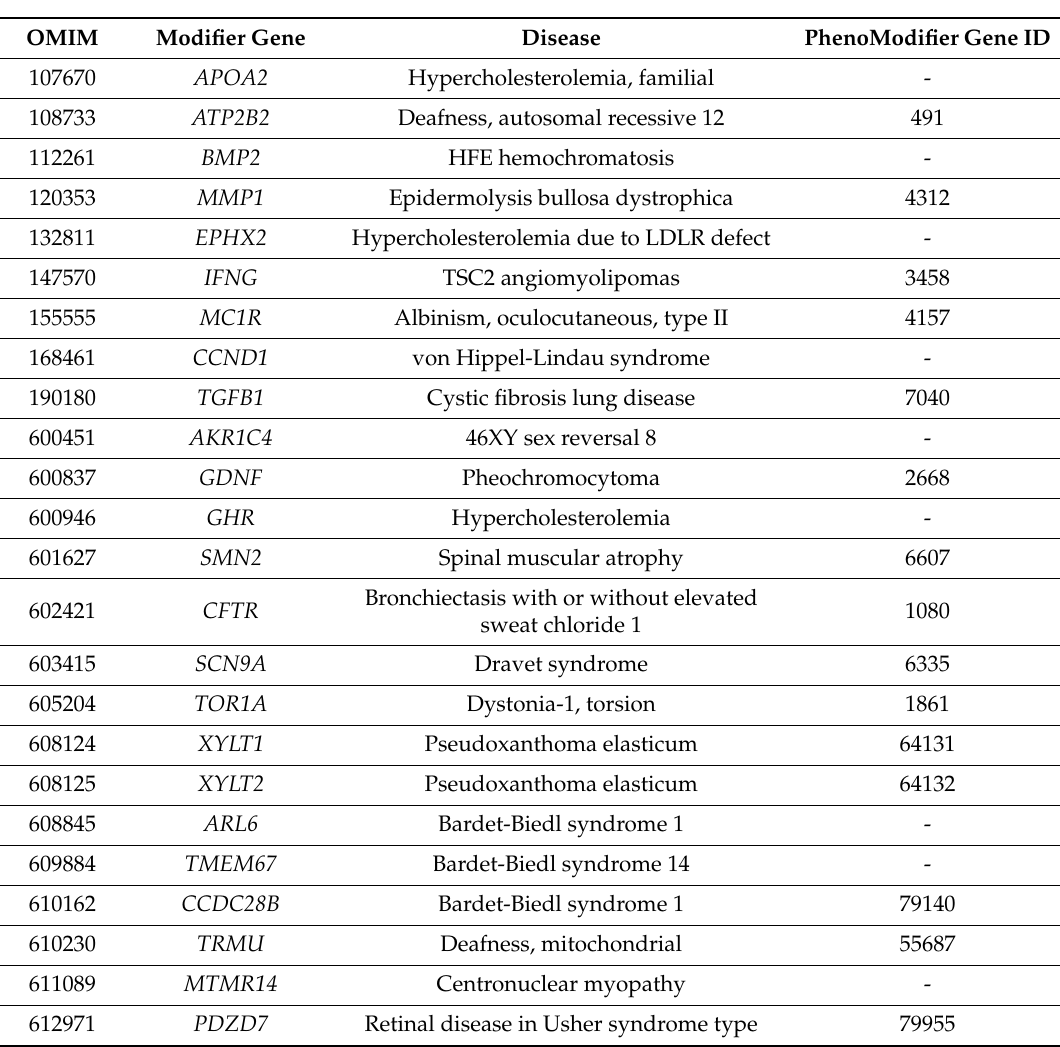
Table 1. Modifier gene for the rare Mendelian disorder found in the Online Mendelian Inheritance in Man (OMIM)